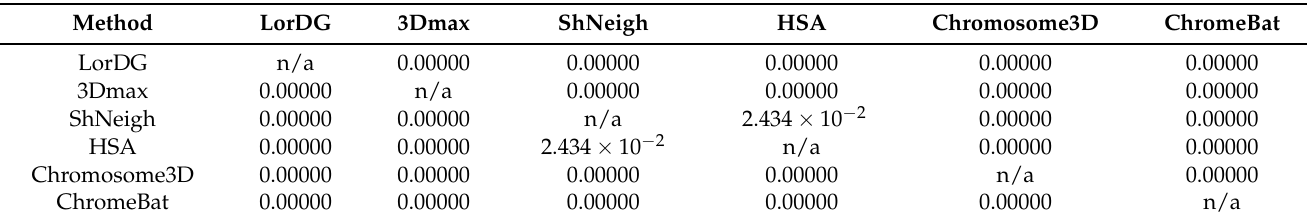
Table 1. The Mann–Whitney Test on Chromosome 1. Each method was used to generate 35 independent structures and the reported number is the P value associated with the Mann–Whitney Test between the column and row methods. For space, the P value has been truncated to five